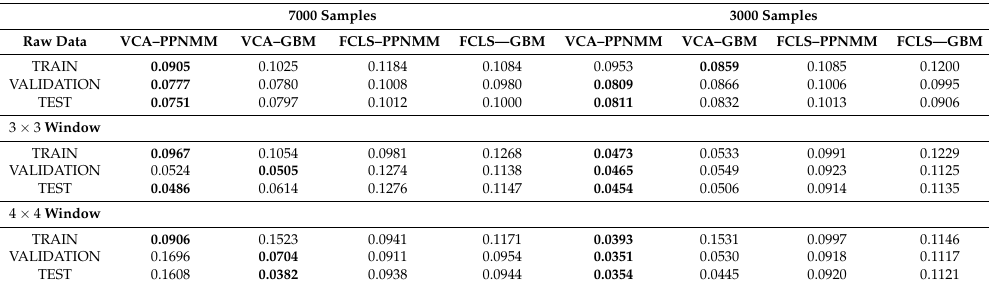
Table 6. Abundance estimation error on Jasper Ridge data showing training, validation and testing accuracy on the individual and hybrid methods with different training samples and different window size vectors. The best results are shown in bold.